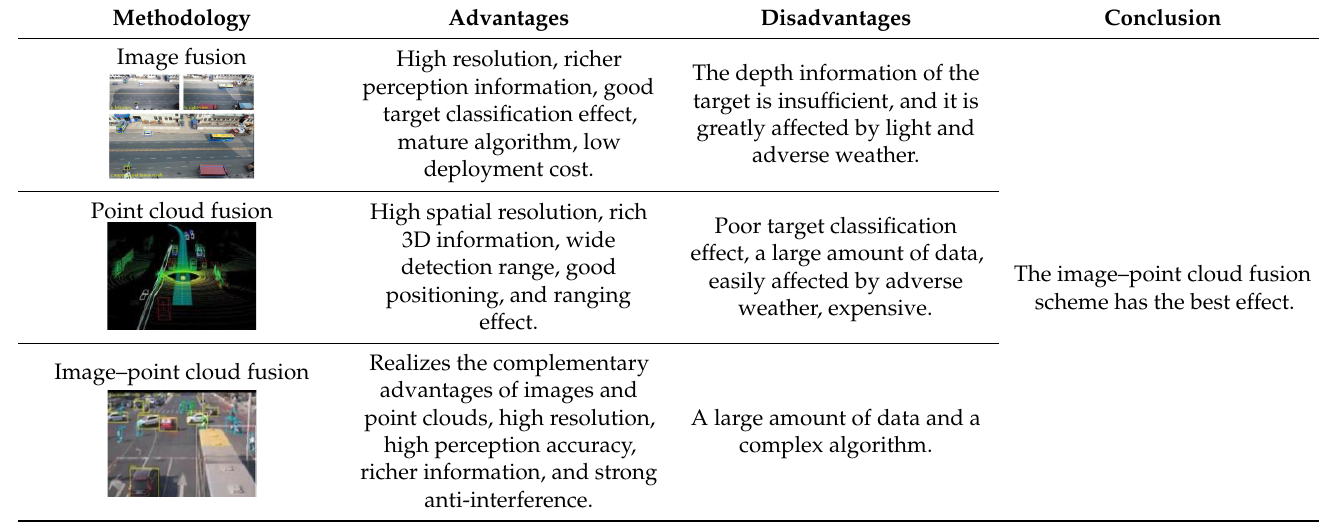
Table 5. Comparison of the advantages and disadvantages of three different fusion methods.